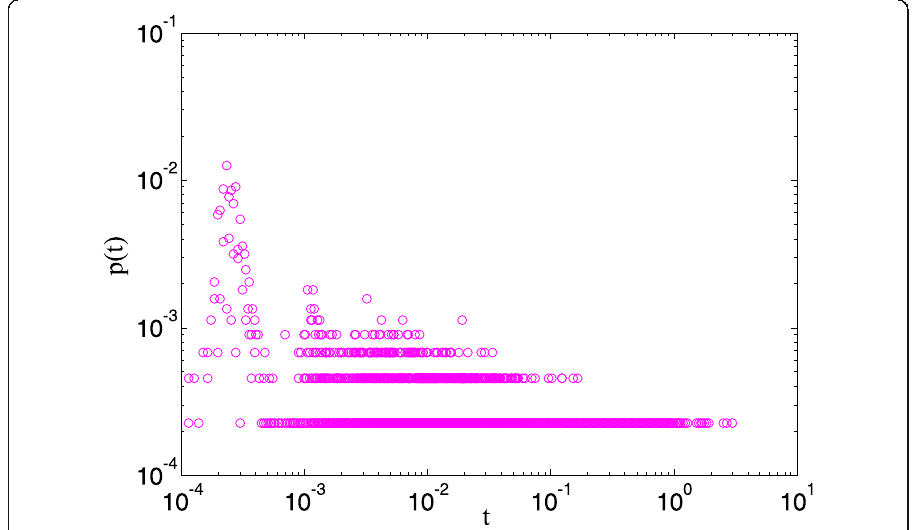
Fig. 1 Virtual machine placement target optimization test sample